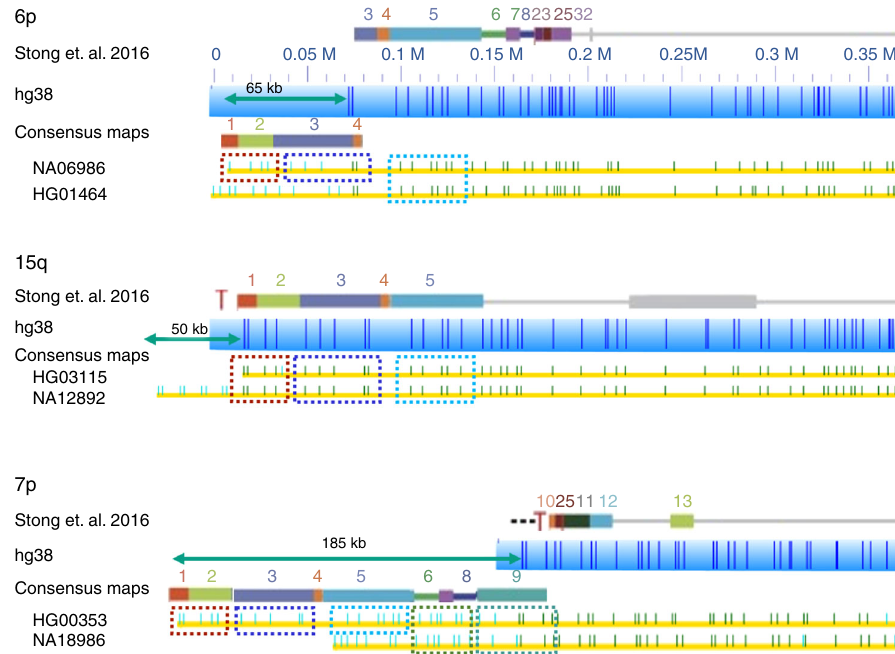
Fig. 6 Chromosome- and population-dependent distribution of paralogy block 3 in subtelomeric regions. Previous subtelomere repeat elements paralogy block references, shown as colored rectangles above each chromosome arm 36 . Yellow rows depict consensus contigs beneath blue bars representing hg38 references. Dark green dashes indicate Nt.BspQI nick sites matching the reference while lighter green dashes represent unmatched nick sites. Teal arrows measure regions not in either reference. Additional paralogy blocks are also shown above these extended regions with dashed boxes indicating regions matching speci fi c blocks. Paralogy block 3, shown by the dashed box in purple, is found on only one haplotype of 6p, on all haplotypes of 15q, and on a less common haplotype of 7p